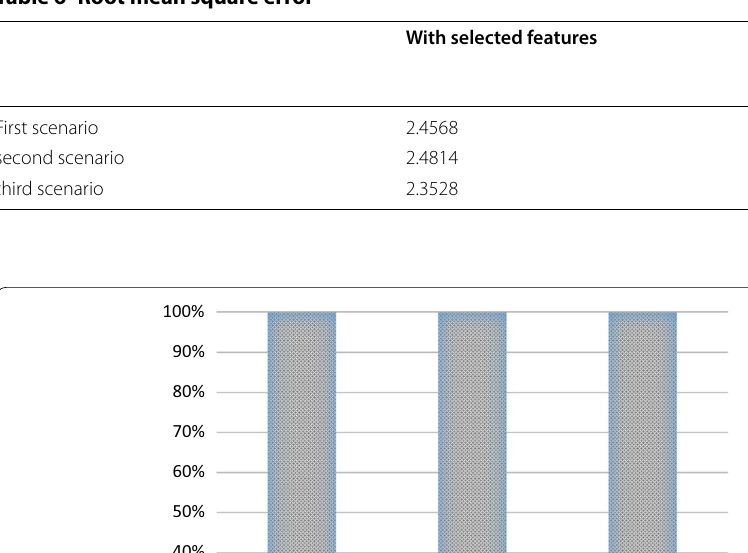
Table 6 Root mean square error